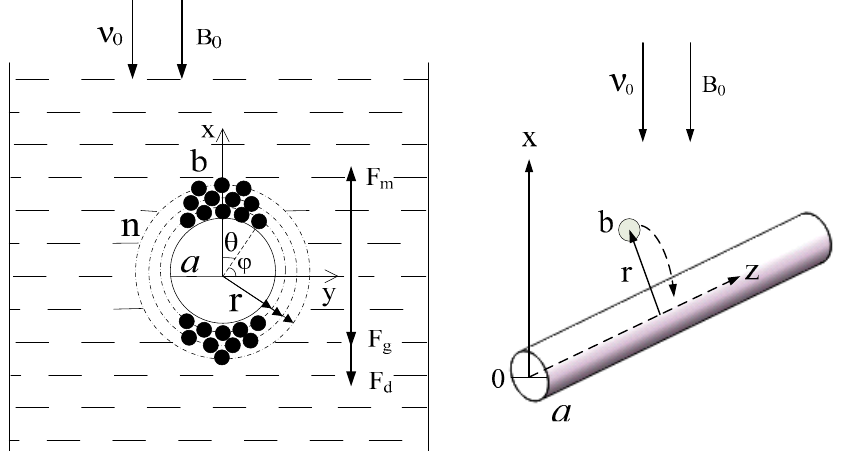
Figure 1. High gradient magnetic separation (HGMS) process ( left ) and magnetic capture of cylindrical wire to magnetic particle ( right ).